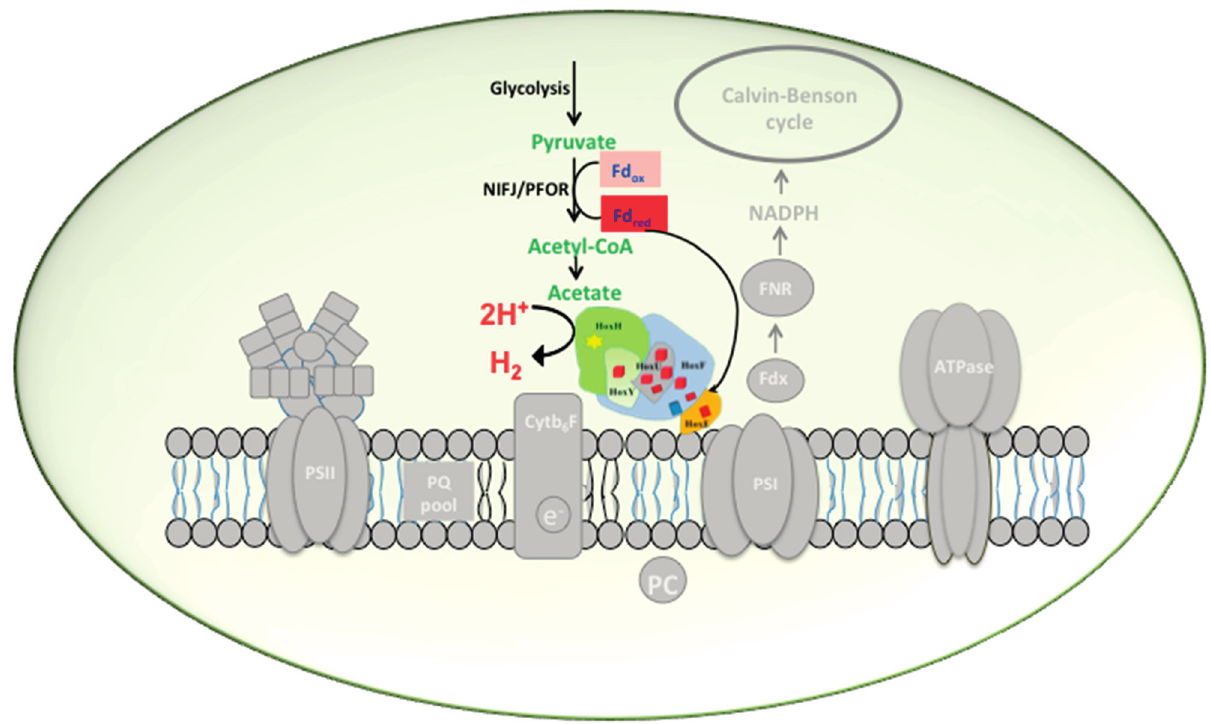
Figure 2. Biochemistry of hydrogen production in Synechocystis PCC 6803 by indirect biophotolysis. In darkness, under anaerobiosis, when the PSII is inactivated, glycogen is catabolized to pyruvate by glycolysis. Pyruvate is further oxidized to acetyl CoA during which ferredoxin is reduced by pyruvate formate oxidoreductase (PFOR). Reduced ferredoxin has the capacity to directly donate electrons to the Hox